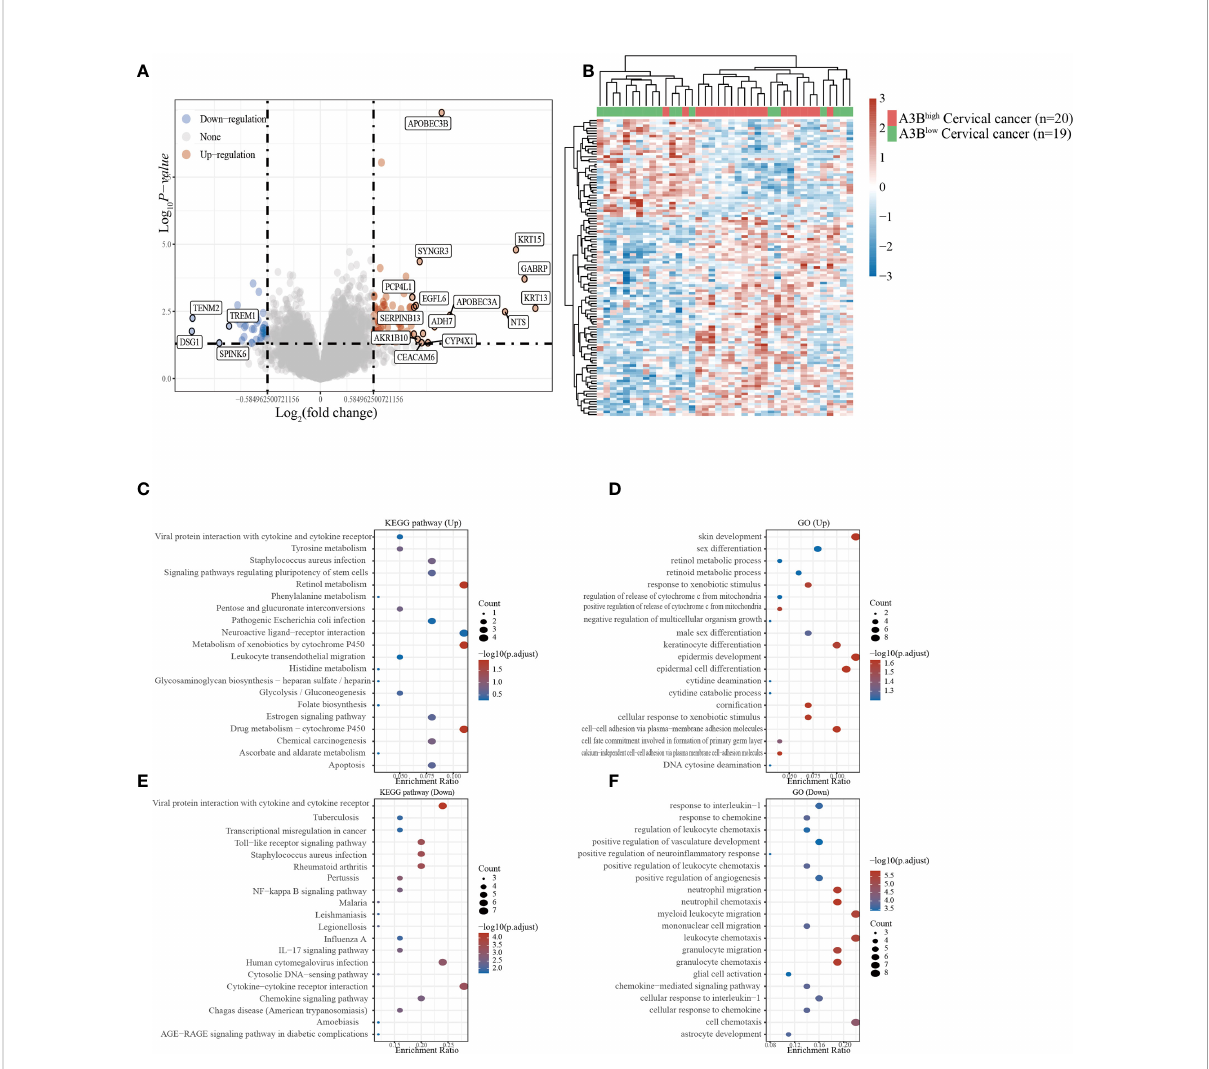
FIGURE 3 Different gene expression patterns and enrichment analyses of APOBEC3B high and APOBEC3B low expression in cervical cancer in GSE26511. (A) A volcano plot for differential gene expression in high and low A3B expression in GSE26511. In total, 78 upregulated genes and 38 downregulated genes were identi fi ed. (B) The heatmap analysis of differential genes. (C) KEGG pathway analysis of upregulated genes. (D) Analysis of upregulated genes. (E) KEGG pathway analysis of downregulated genes. (F) GO analysis of downregulated